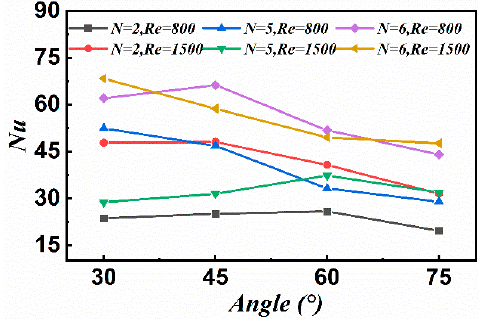
Figure 10. Variations of 𝑁𝑢 with deflector angle at P = 5 mm.